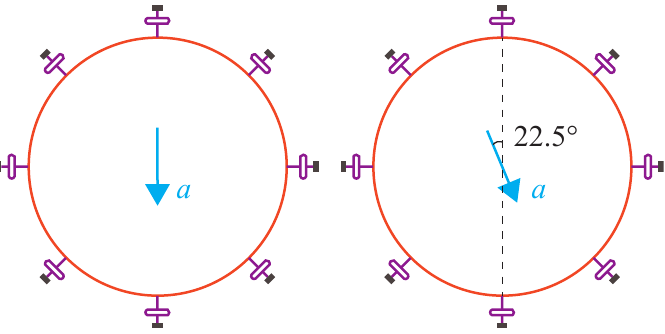
Figure 9. Schematic diagram of acceleration application direction.